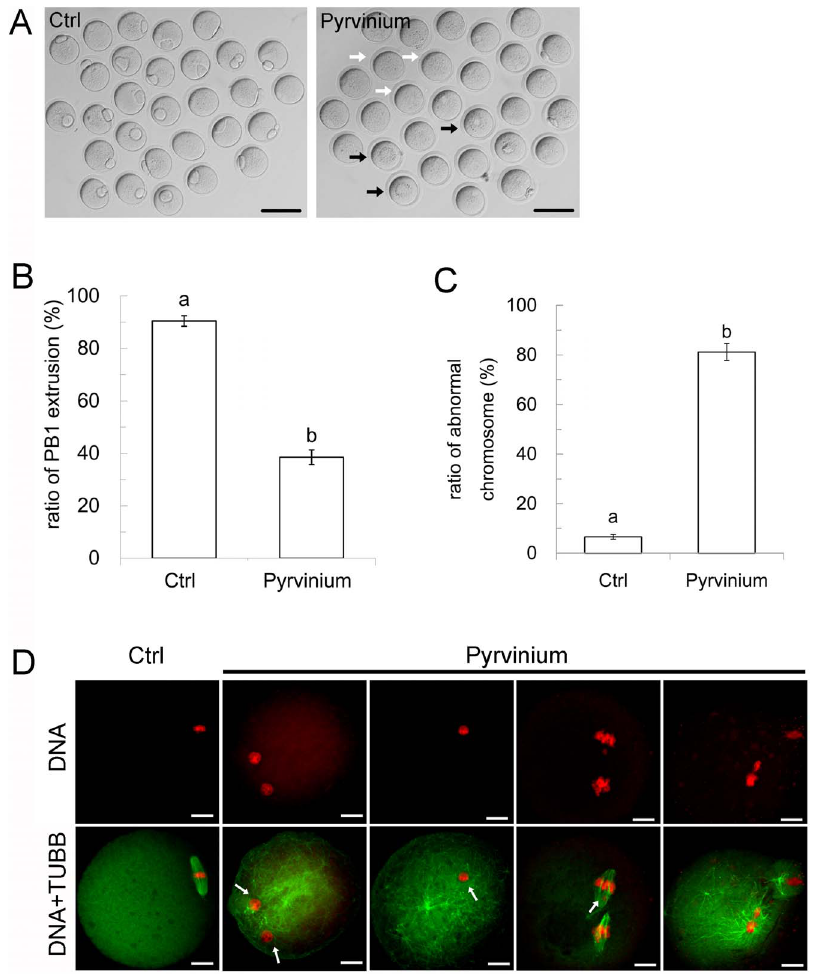
Figure 4. Pyrvinium pamoate allosteric activated CK1 a leading to oocyte maturation fail. (A) Representative images of oocytes incubated in PP-containing medium and drug-free medium for 12 hours. Most of the oocytes in the control group reached the MII stage (left), whereas most of the oocytes in the PP-containing medium did not extrude PB1 (right). White arrow indicates representative oocyte without PB1. Black arrow indicates representative oocyte with a dark circle in the cytoplast. (B) PP causes decrease in PB1 extrusion. t-Test was used to determine significance of difference for PB1 extrusion. Different superscripts on the bar indicate statistical difference (p , 0.01). (C) PP caused chromosome abnormalities. At least 30 oocytes were evaluated for each repeat. t-Test was used to determine the significance of difference for abnormal chromosome occurrence. Different superscripts on the bar indicate statistical difference (p , 0.01). (D) Confocal microscopy image of PP caused chromosome abnormalities. Column 1 showed normal spindle and chromosome congression in the control group. Column 2 and 3 presents abnormally congressed chromosomes (arrow) and spindle assembly failure. Column 4 presents lagging chromosomes (arrow). Column 4 presents oocyte with extruded PB1 but chromosome disorders and failed spindle assembly. Green: b -tubulin. Red: DNA. Scale bar=10 m